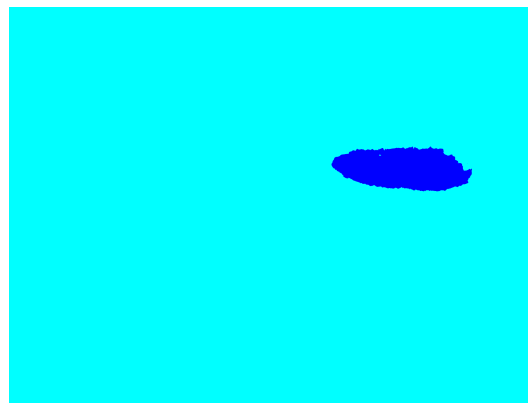
Figure 5. University open theater image with initial seed rectangles used to apply segmentation and space calculation algorithm of single green area